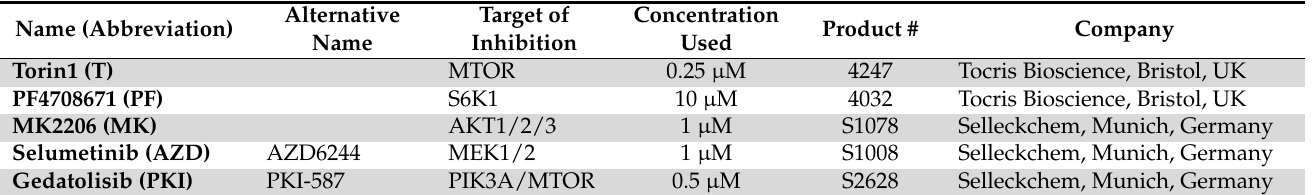
Table 1. Small molecule inhibitors used in the study. All inhibitory compounds are listed concerning their target of inhibition, the final concentration used in the study. Additionally, the product number and the company are